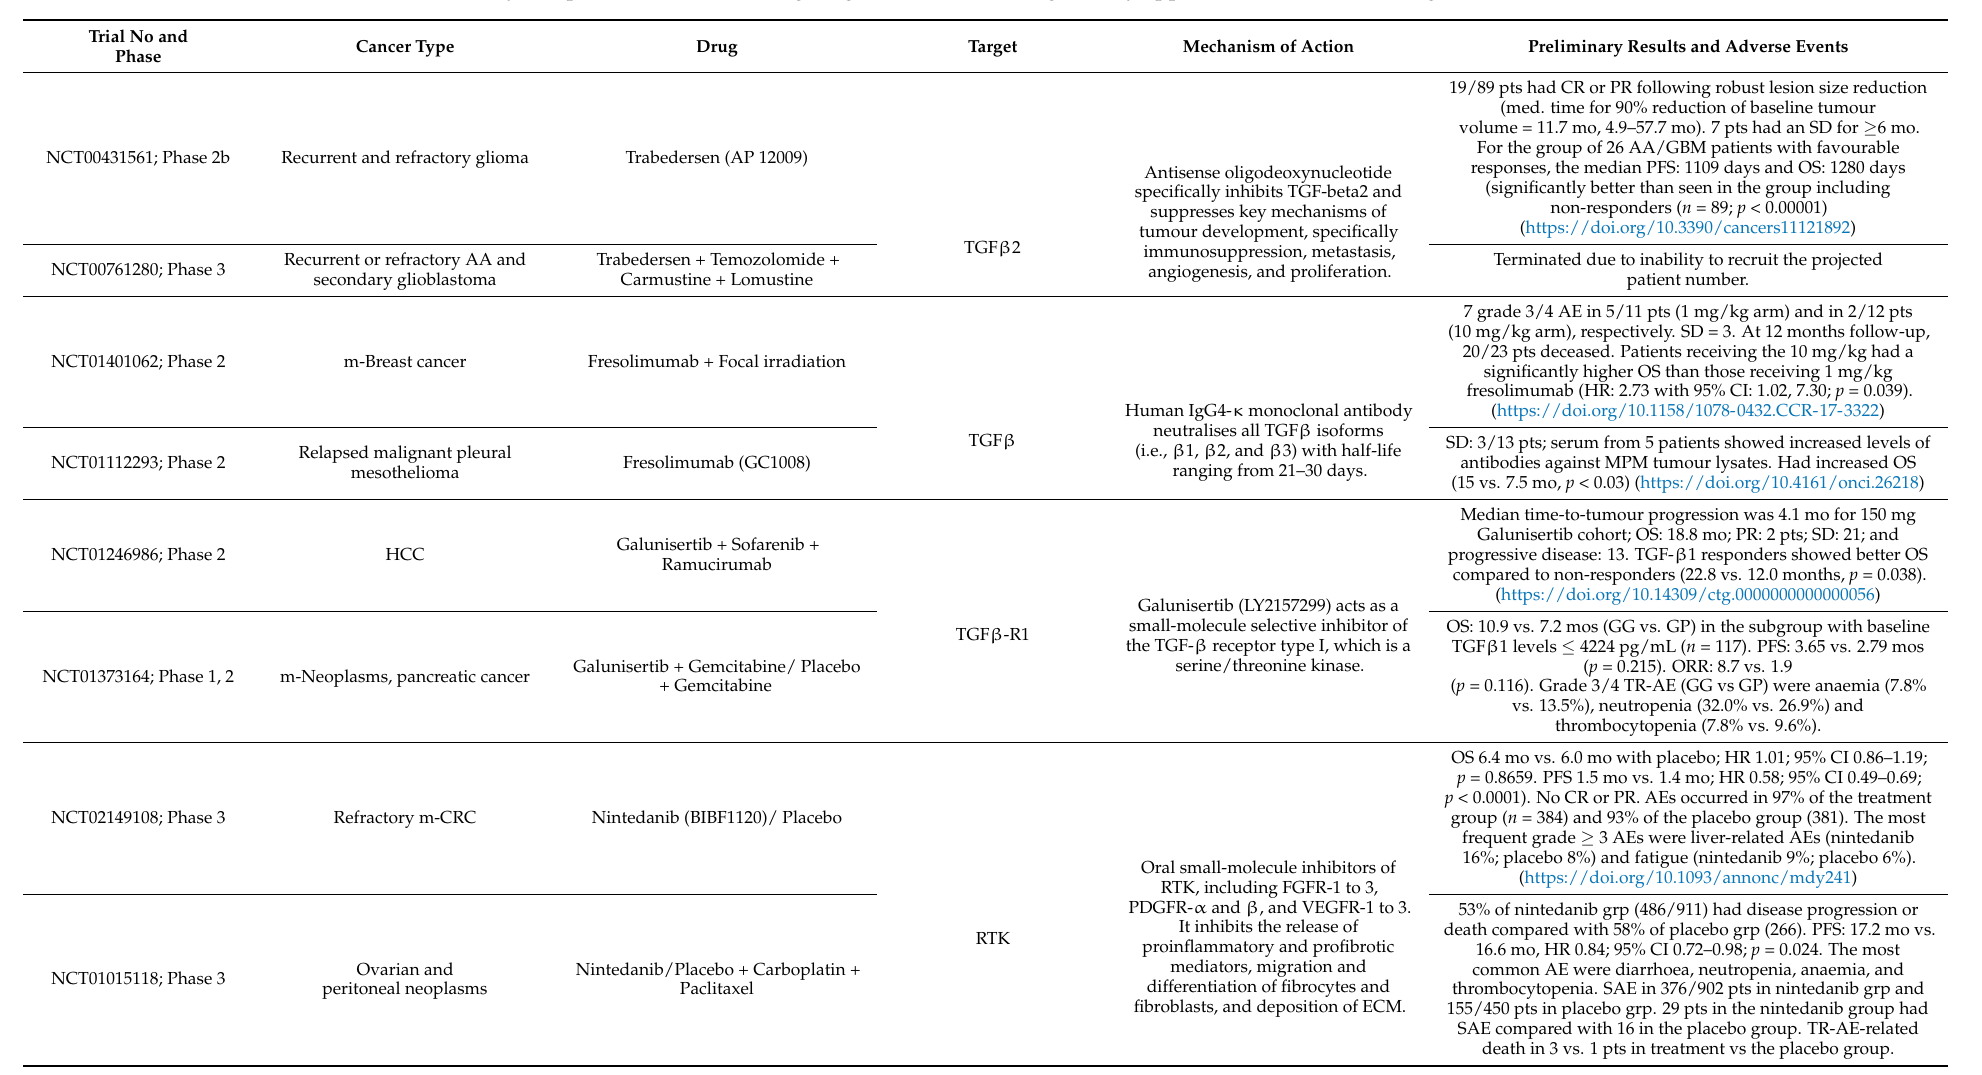
Table 3. Recently completed clinical trials targeting ECM (not including already approved and marketed